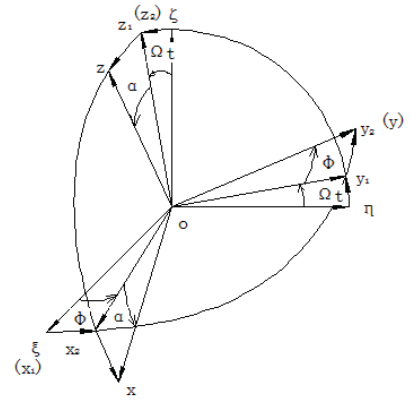
Figure 5. Transformation of the reference